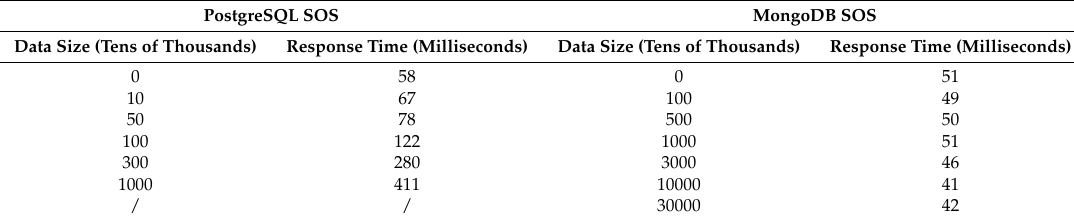
Table 3. The performance comparisons of the SOS InsertObservation